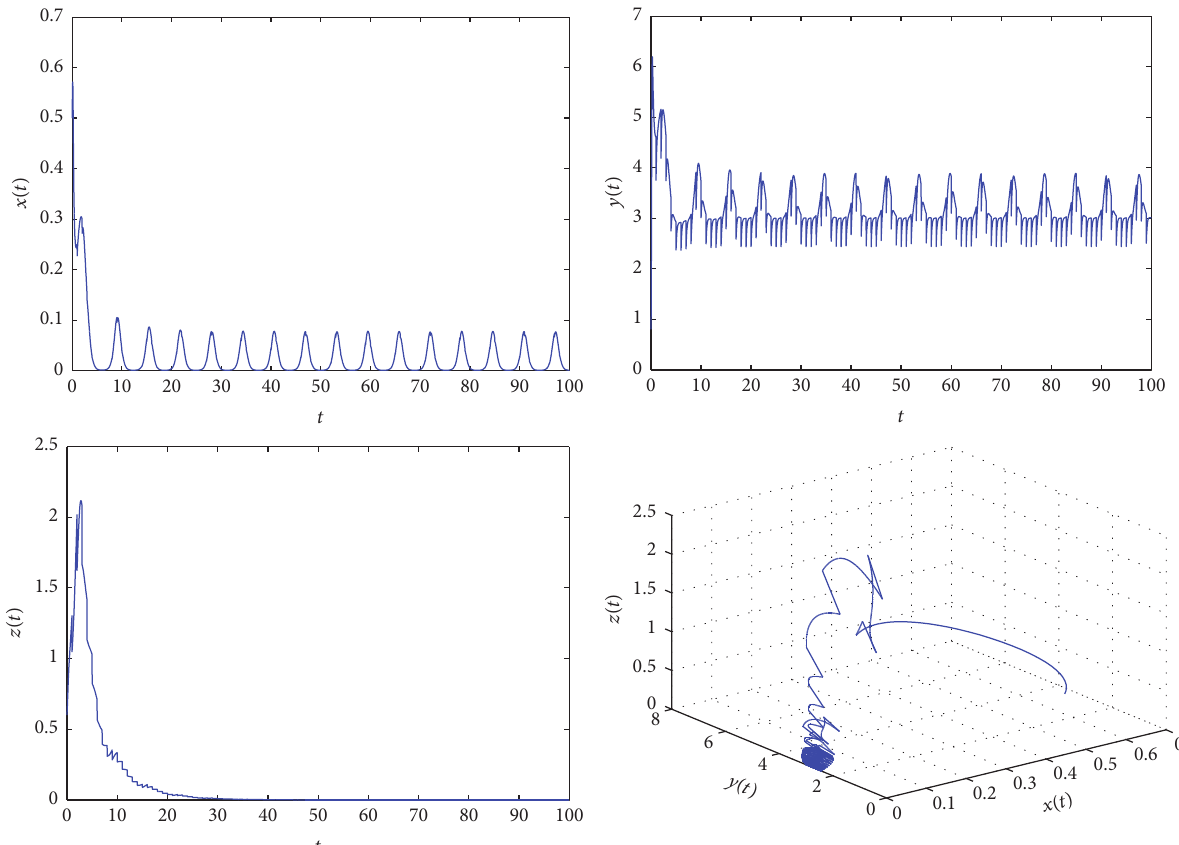
Figure 2: Extinction of the higher predator of system (1) with 𝜙 1 (𝑠) = 𝑥(0) = 0.5 , 𝜙 2 (𝑠) = 𝑦(0) = 0.8 , 𝜙 3 (𝑠) = 𝑧(0) = 0.6 , 𝑠 ∈ [−𝜏,0].